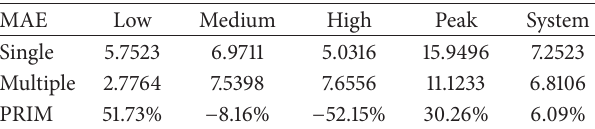
Table 5: Performance evaluation results of MAE between the single and the two-stage multiple SVM in June 2010.